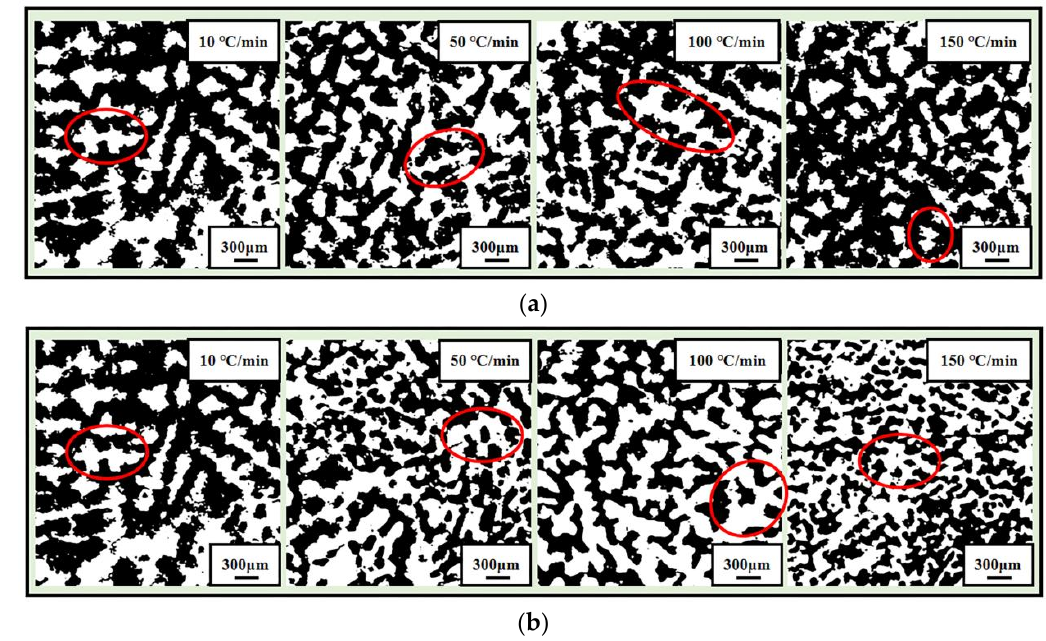
Figure 6. OM solidification structures of the studied 70 steel by HT-CSLM at room temperature (typical dendrites are shown in the red circle). ( a ) Cooling rate was changed at the stage of the superheat elimination. ( b ) Cooling rate was changed at the stage of liquidus to solidus.